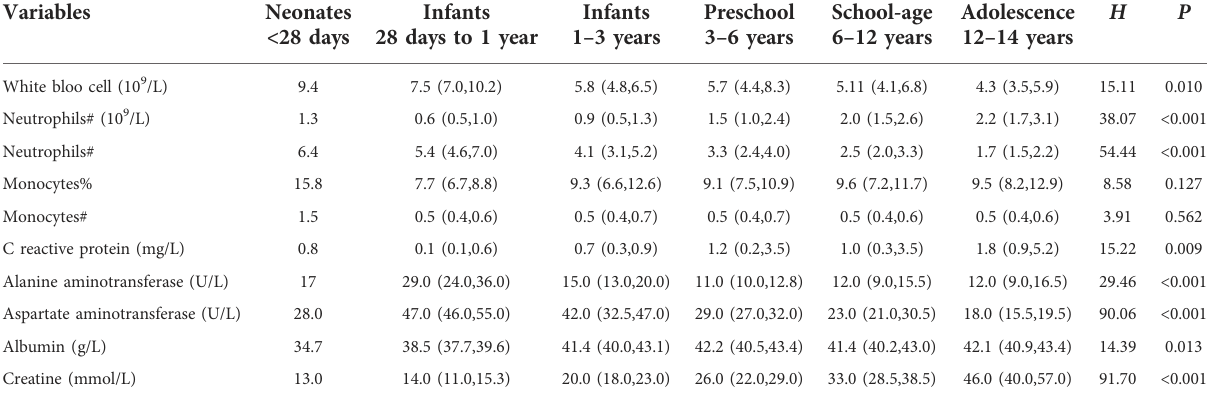
TABLE 4 The level of lab examinations between age groups among children with omicron